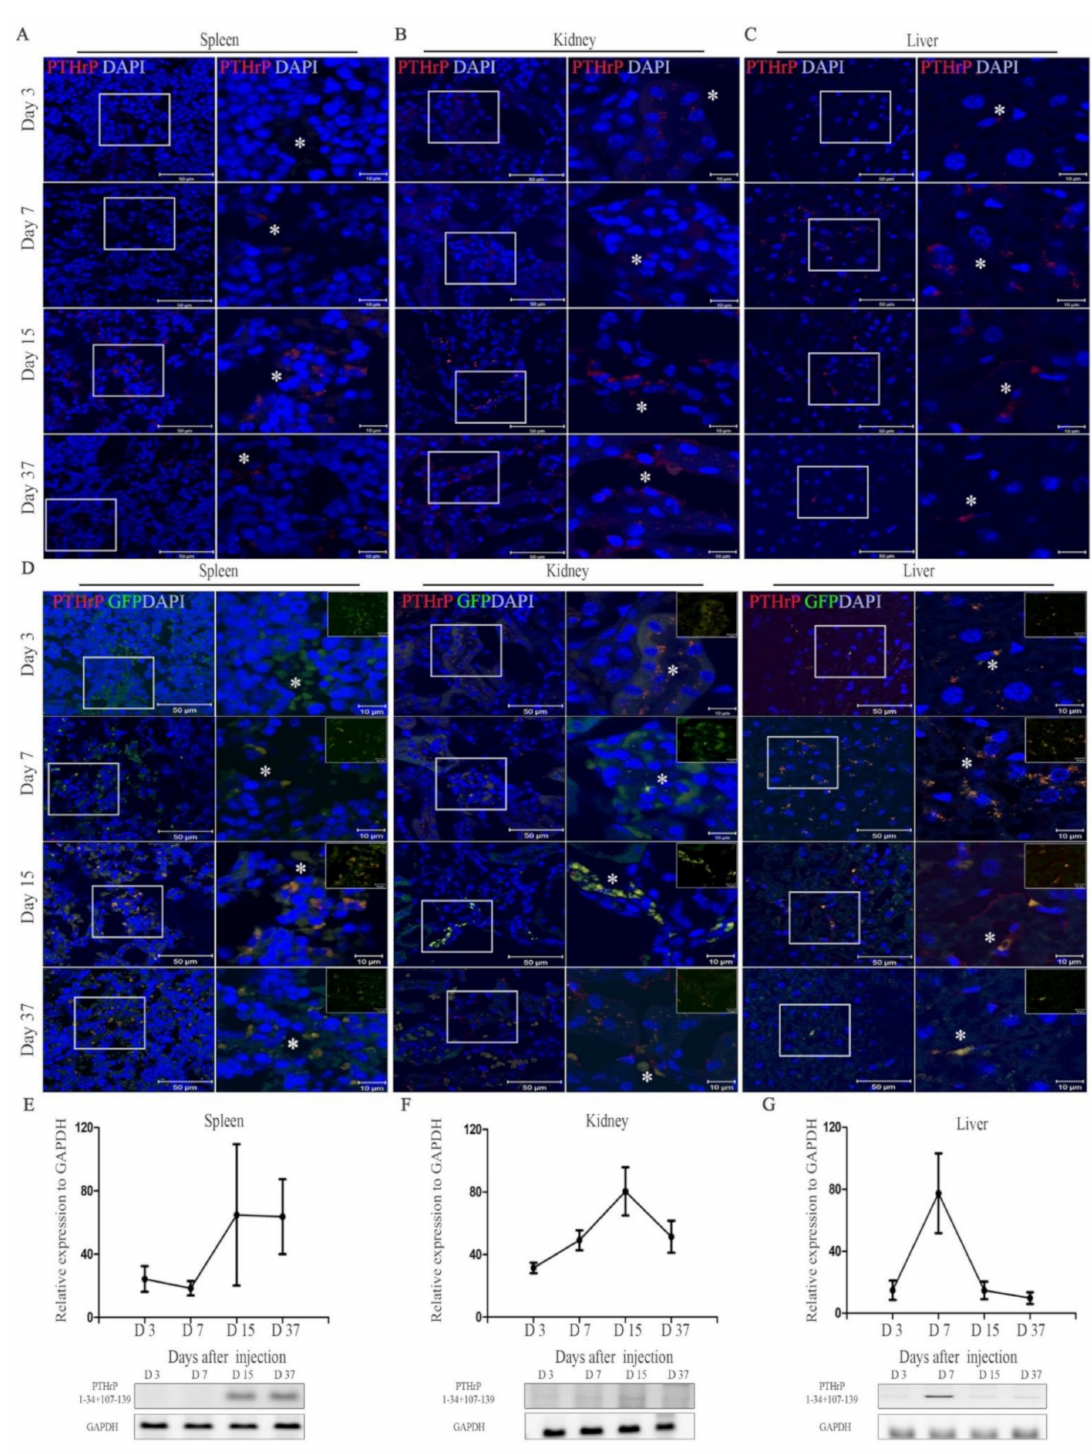
Figure 2. Expression of mcPTHrP 1–34+107–139 after in vivo injection. Immunofluorescence images of the detection of the PTHrP protein in the ( A ) spleen, ( B ) kidney, and ( C ) liver, 3, 7, 15, and 37 days after the intravenous injection of mc PTHrP 1–34+107–139 into the tail vein of mice; scale bar = 50 and 10 µ m. ( D ) Immunofluorescence images of the co-localization of PTHrP and GFP in different tissues; scale bar = 10 µ m. Relative expression of the PTHrP 1–34+107–139 gene in ( E ) spleen, ( F ) kidney, and ( G ) liver tissues collected 3, 7, 15 and 37 days post-injection. Results are given as the mean band intensity normalized to that of GAPDH (Image J software). White box indicates the magnified region of interest. A white asterisk indicates the merged region of